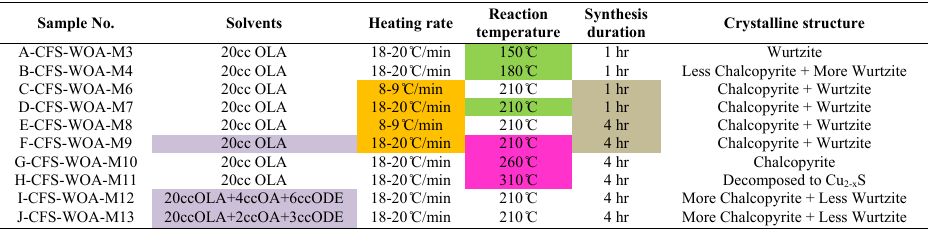
Table 1. Experimental detail for one-pot thermolysis synthesis of CuFeS